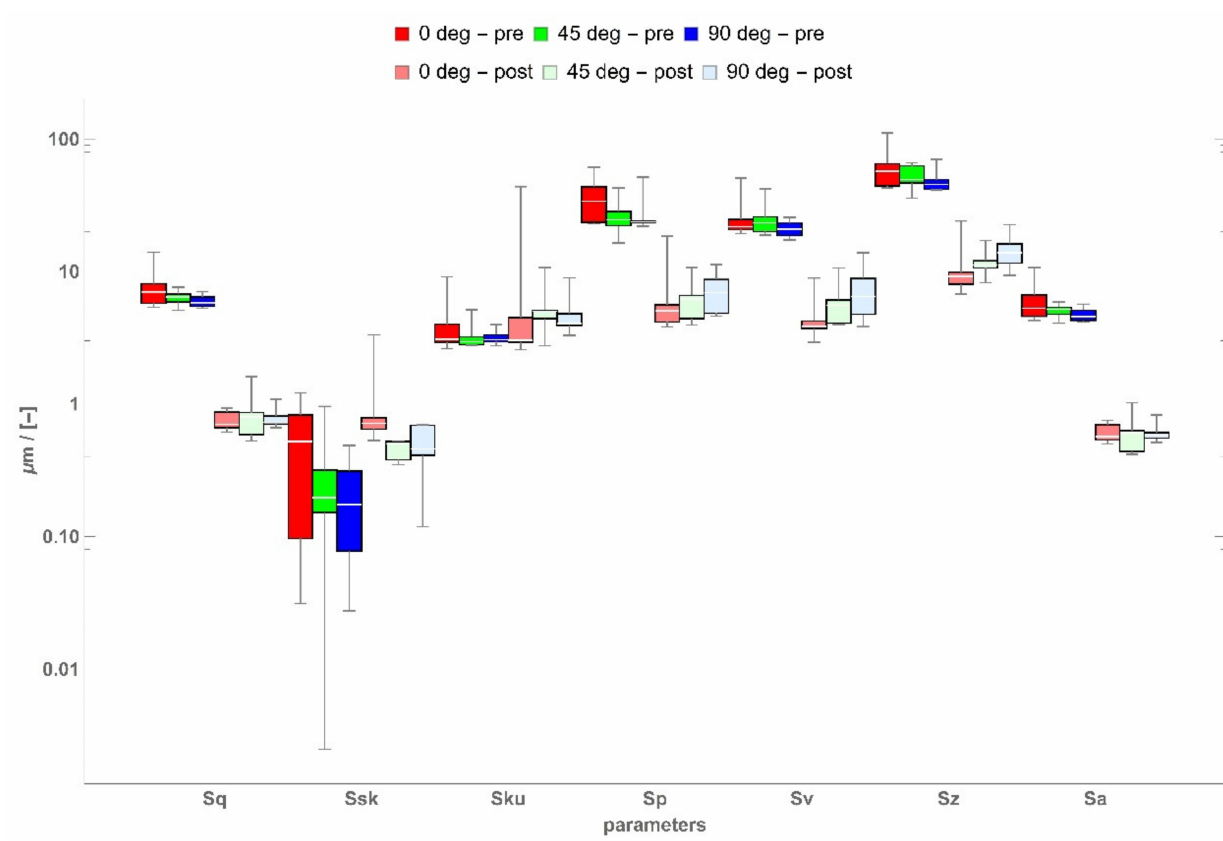
Figure 4. Height areal